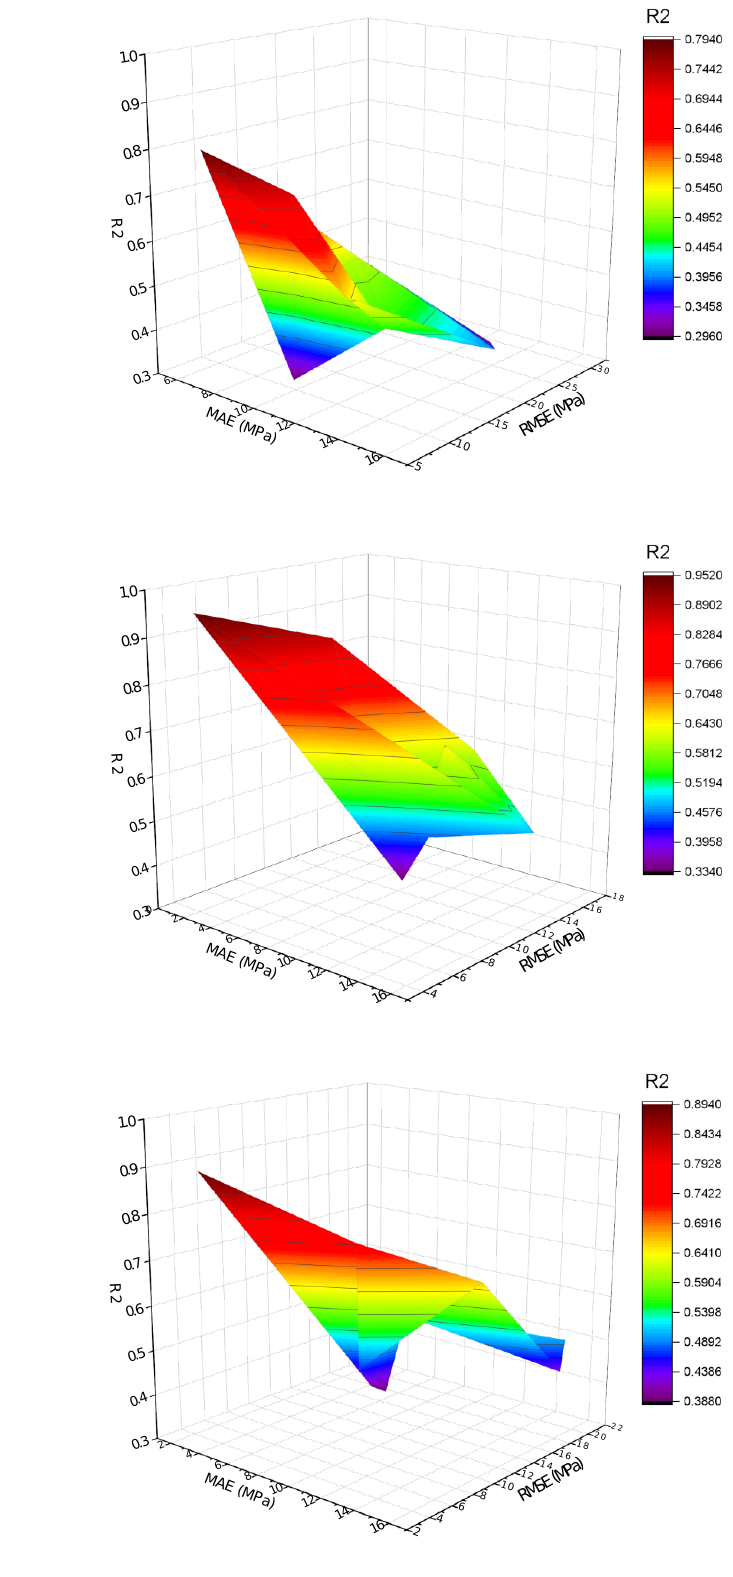
Figure 16. Compressive strength statistical representation: ( a ) MLPNN; ( b ) MLPNN-AdaBoost; ( c ) MLPNN-Bagging.